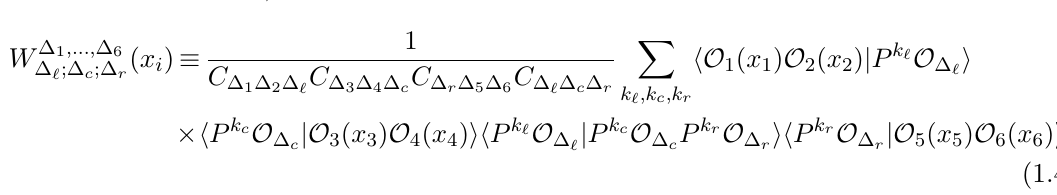
Figure 3. The graphical representation of the global scalar six-point block in the OPE channel, W (cid:1) 1 ;:::; (cid:1) 6 ( x i ) (LHS), and the leading term in its holographic representation (RHS). To (cid:1) ‘ ;(cid:1) c ;(cid:1) r